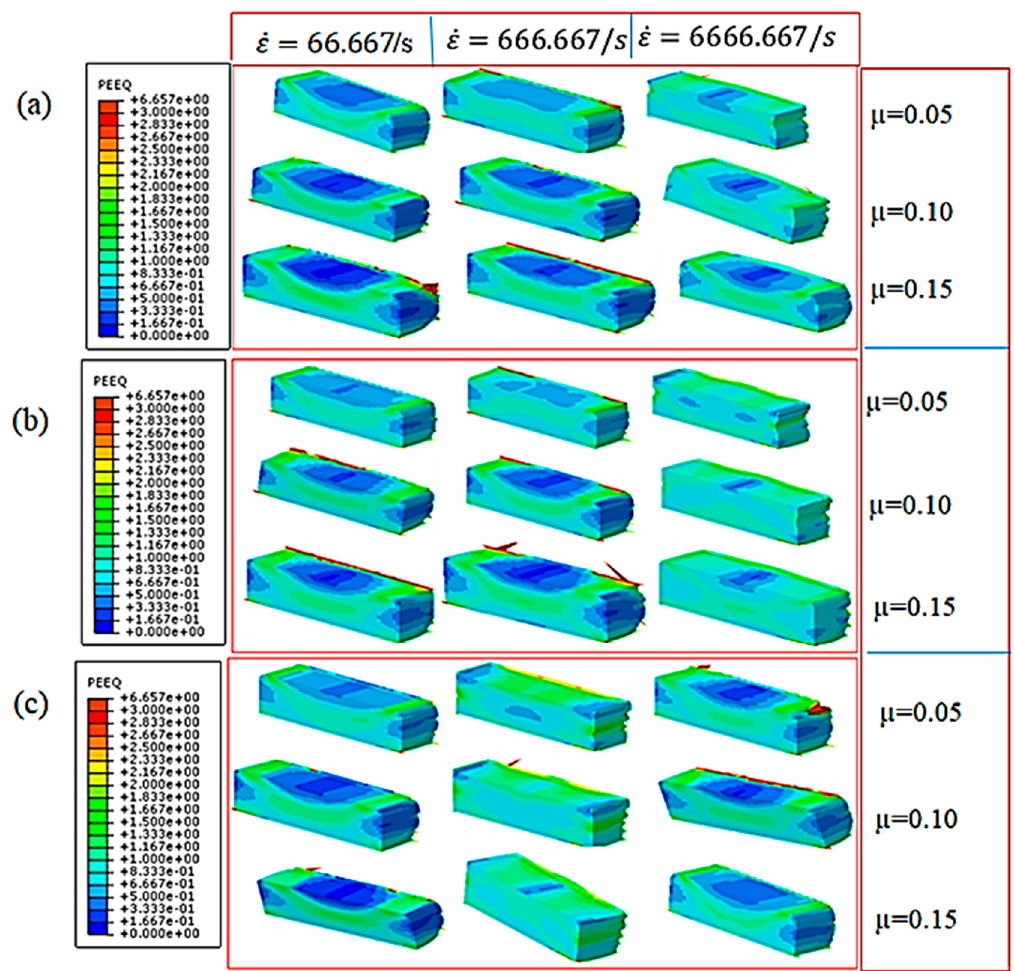
◦ C; ( b ) at 250 ◦ C; ( c ) 500 ◦ C. Figure 7. Strain distribution contour plot ( a ) at 25 °C; ( b ) at 250 °C; ( c ) 500 °C. Figure 7. Strain distribution contour plot ( a ) at 25 Moreover, the effective strain as a function of the strain rate was determined and is shown in Figure 8. It was observed that by increasing the strain rate, the effective strain increased accordingly. For a friction coefficient of 0.05 at high temperature of 500 ◦ C, the effective strain increased from 83.2% to 87.2% when the strain rate increased from 66.67 s − 1 to 666.67 s − 1 , respectively, as depicted in Figure 8c. The relationship of the effective strain and strain rate at various temperatures and friction coefficients is shown in Figure